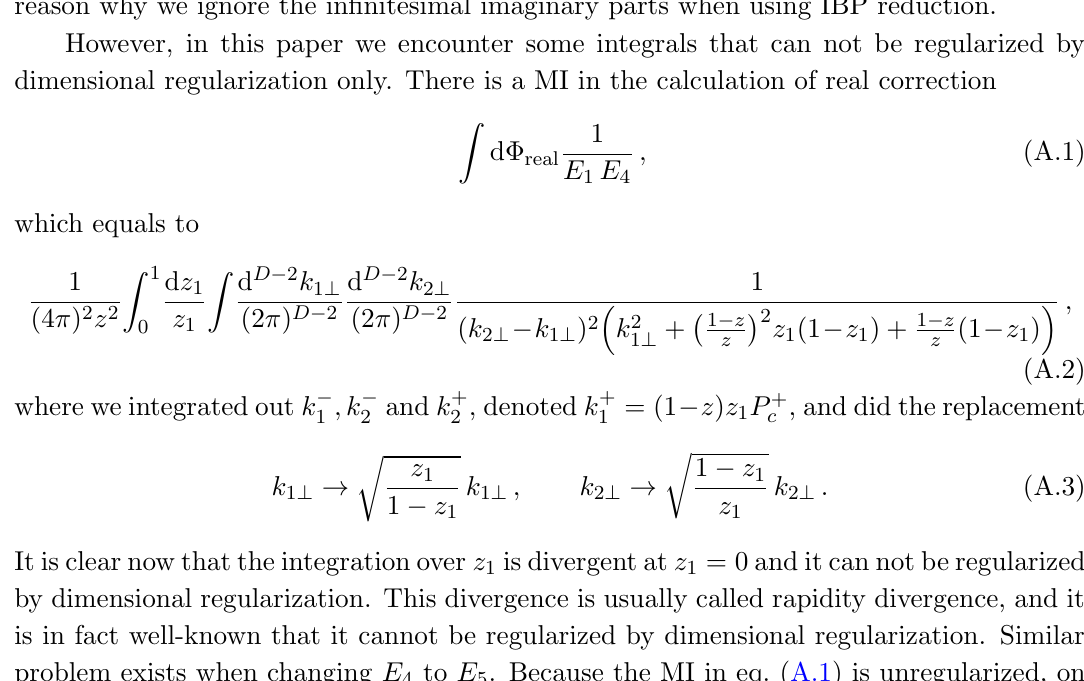
Figure 11 . SDCs of the fragmentation function of g ! b (cid:22) b ( 1 S [8] line is for d [8] ( z ) (cid:2) (96 m 3 = 5), while the solid line is for b LO choices (cid:22) r = (cid:22) f = 2 m b . The bands are obtained by varying the renormalization scale (cid:22) f by a factor of